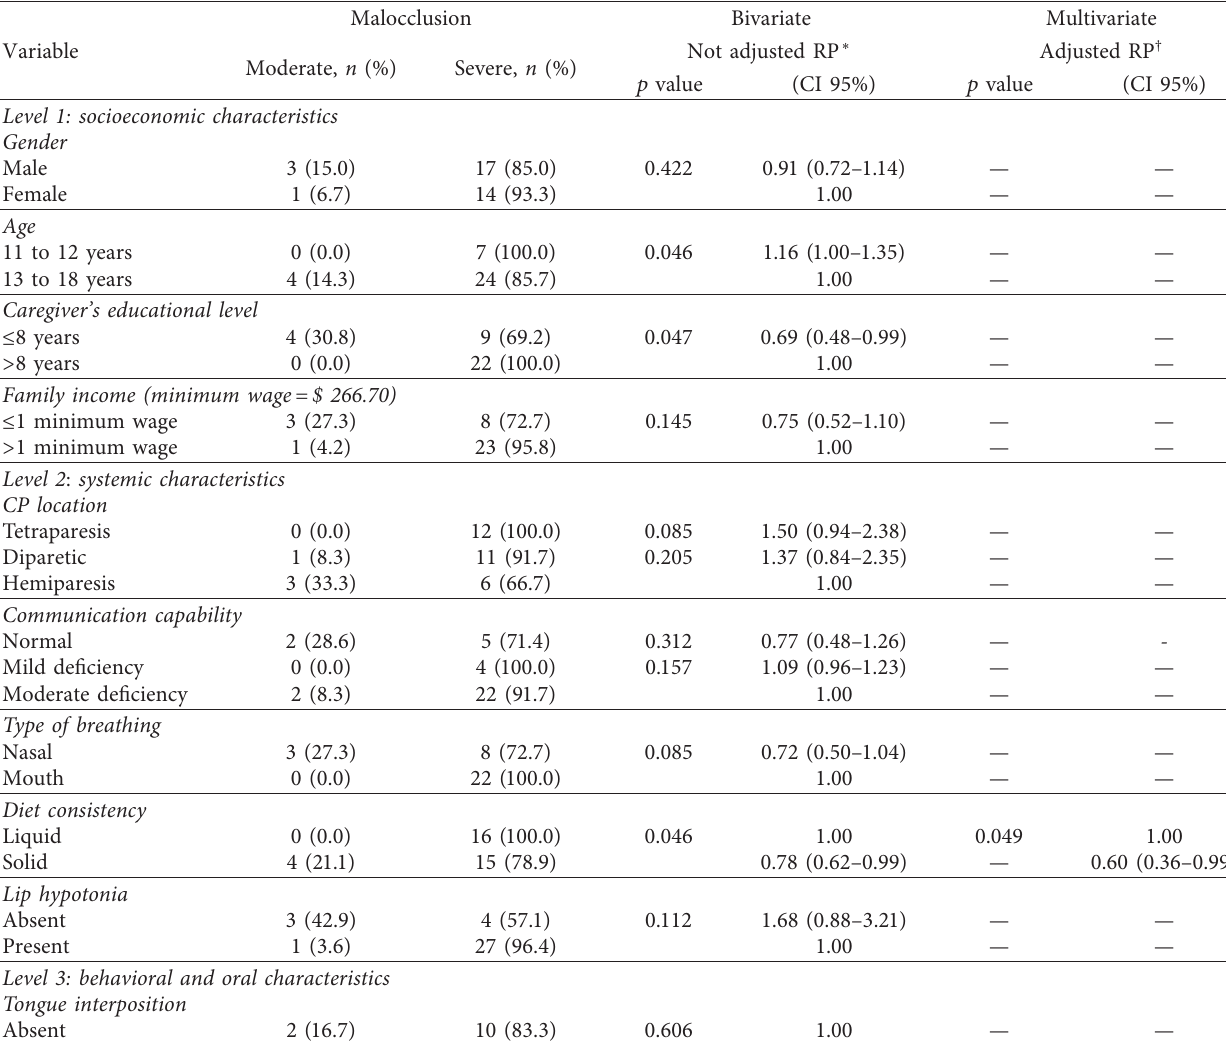
Table 5: Distribution of children and adolescents with CP models in Poisson bivariate and multivariate regression models for the presence of severe malocclusion (DAI > 30) and independent